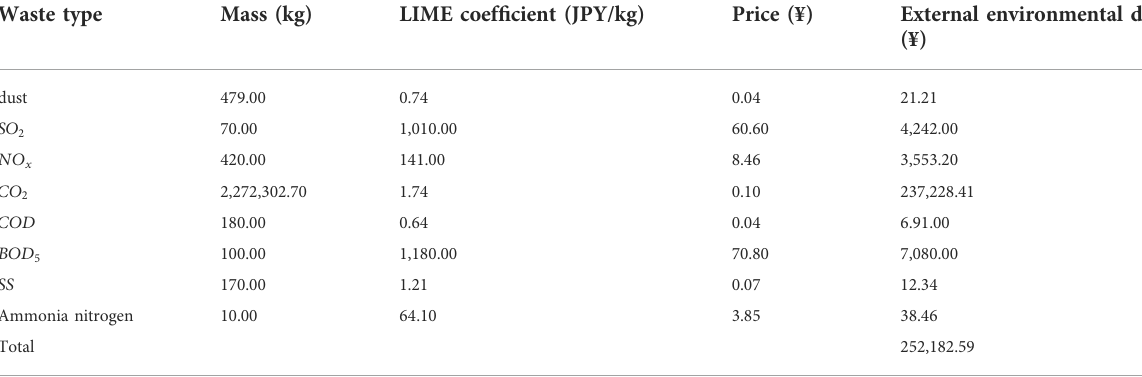
TABLE 7 Waste generation and environmental cost budget.